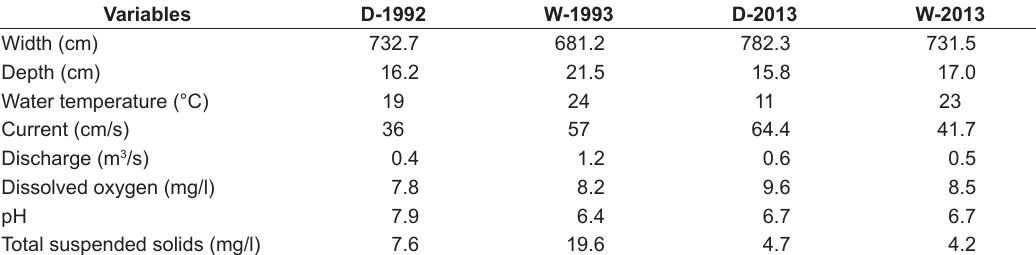
Table 2. Average value of limnological variables used to characterize the studied stretch of Capivara River, analyzed in 1992, 1993 and 2013, in one month of the dry season (D- August) and one of the wet season (W-